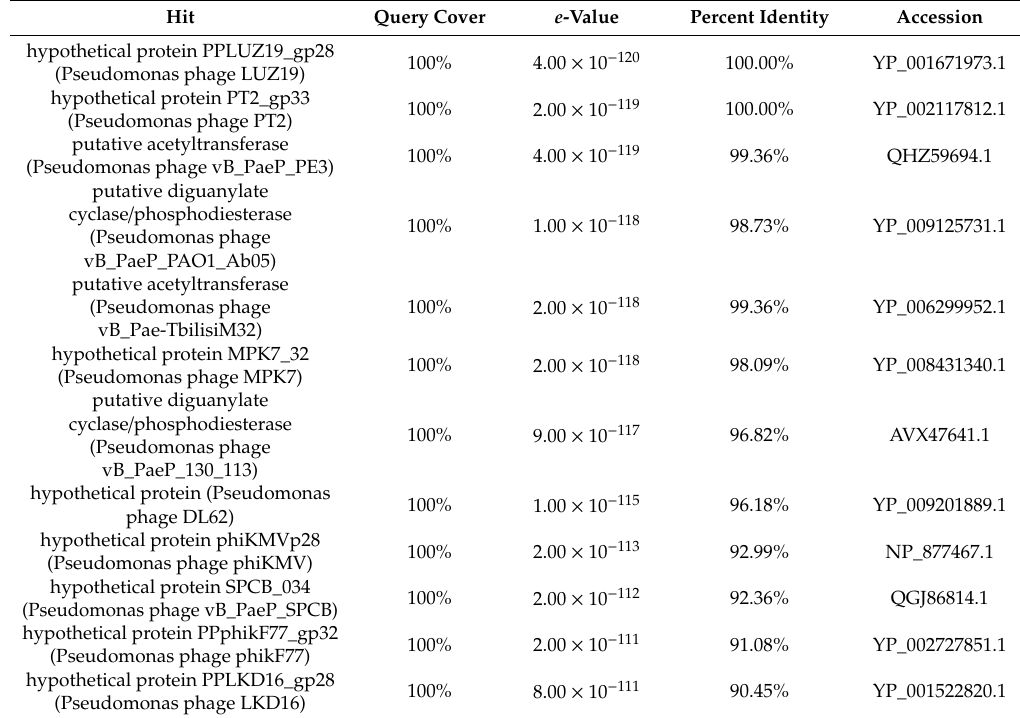
Figure A7. Analysis of P. aeruginosa knockouts of identified unfoldases. ( A ) Markerless knockout mutants created in genetic background of P. aeruginosa rpoA::strep rac . Shown are PCRs with primers 600 bp up- and downstream target gene. ( B ) Microbiological characterization of single and double knockouts, with (left) and without (right) induction of the phage GNAT. ( C ) Affinity purifications of RNAP complex using the Strep-fusion at the C-terminus of the α RNAP subunit, with and without phage infection. Table A1. Conservation of Rac among Krylovirinae